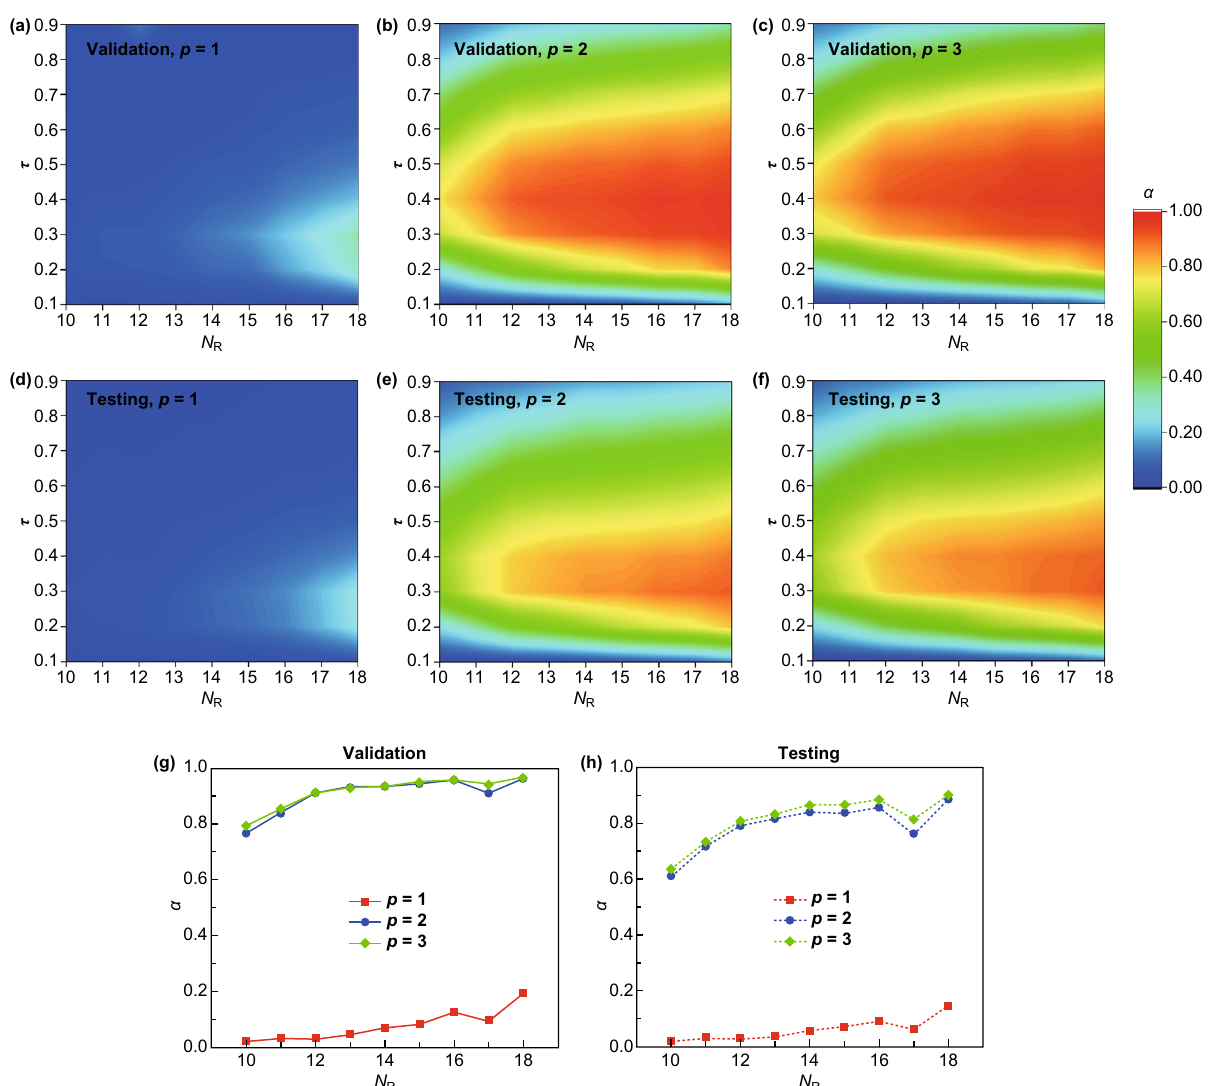
Fig. 6 Parametric study and optimal performances of predicting multiple vacancies. a – c Testing accuracies of kernel degree p ∈ { 1,2,3 } , as a function of N R and threshold 𝜏 . d – f Validation accuracies of kernel degree p ∈ { 1,2,3 } , as a function of N R and threshold 𝜏 . g Validation and h testing accuracies as a function of N R with optimal choices of 𝜏